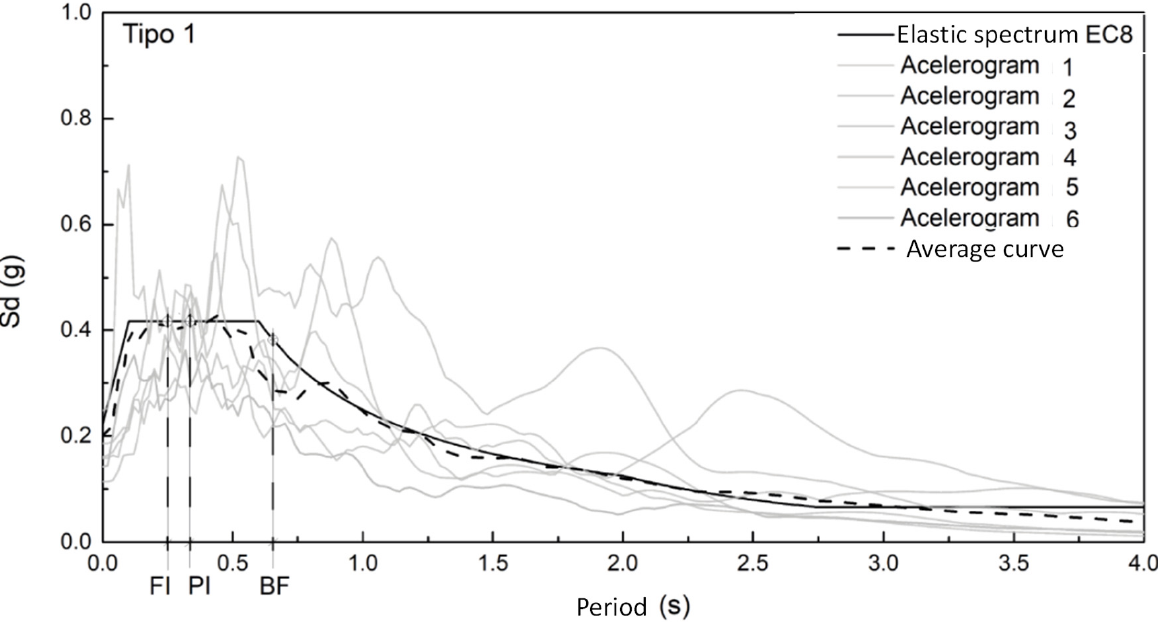
Figure 8. Elastic spectrum (type 1).